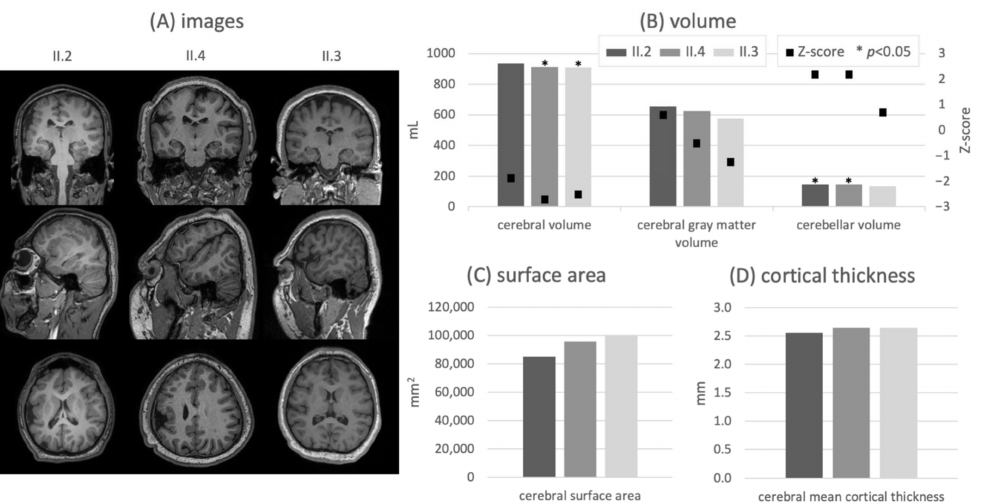
Figure 2. T1-weighted MR images in all orientations with a sagittal view of the right hemisphere ( A ), ICV-normalized volumes and corresponding Z-scores obtained by comparison with an age- matched control group per subject ( B ), brain surface area ( C ) and cortical gray matter thickness ( D ) for all subjects. The quantitative results are consistent with the MR abnormalities and match the highest disease severity seen in patient II.2. * p <